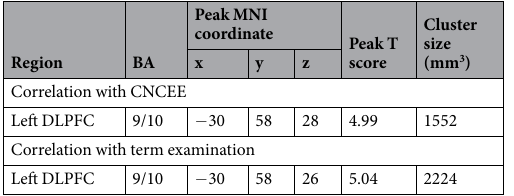
Table 2. Brain regions where gray matter density was associated with academic performance. Note: DLPFC = dorsolateral prefrontal cortex; BA = Brodmann’s area; MNI = Montreal Neurological Institute; CNCEE = Chinese National College Entrance Examination. We set the threshold for significant regions to